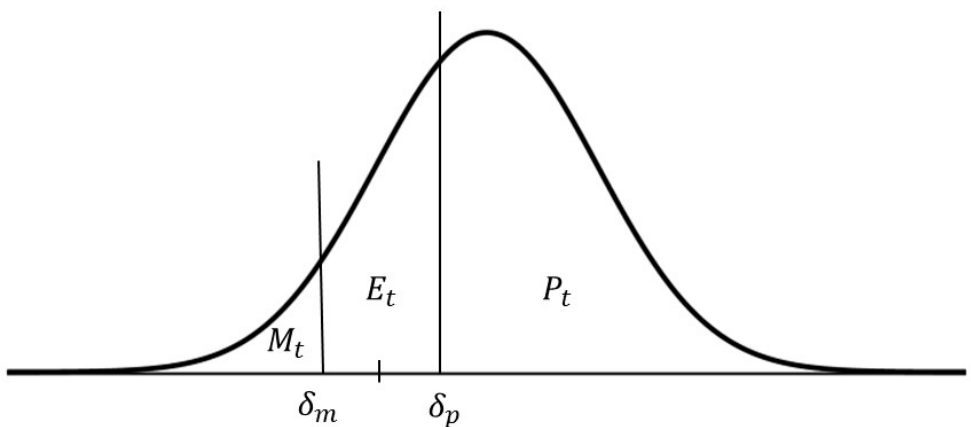
Figure 1. Density function of agents’ average aggregate expectations.